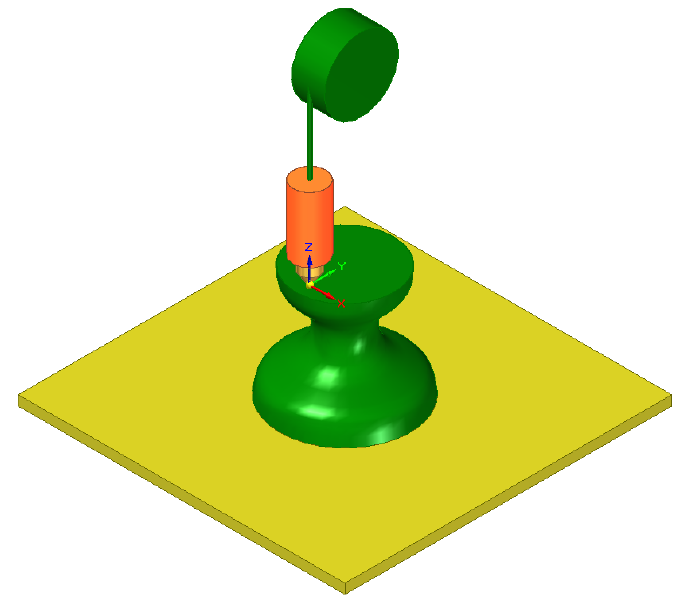
Figure 9. Process of creating an object using FDM.